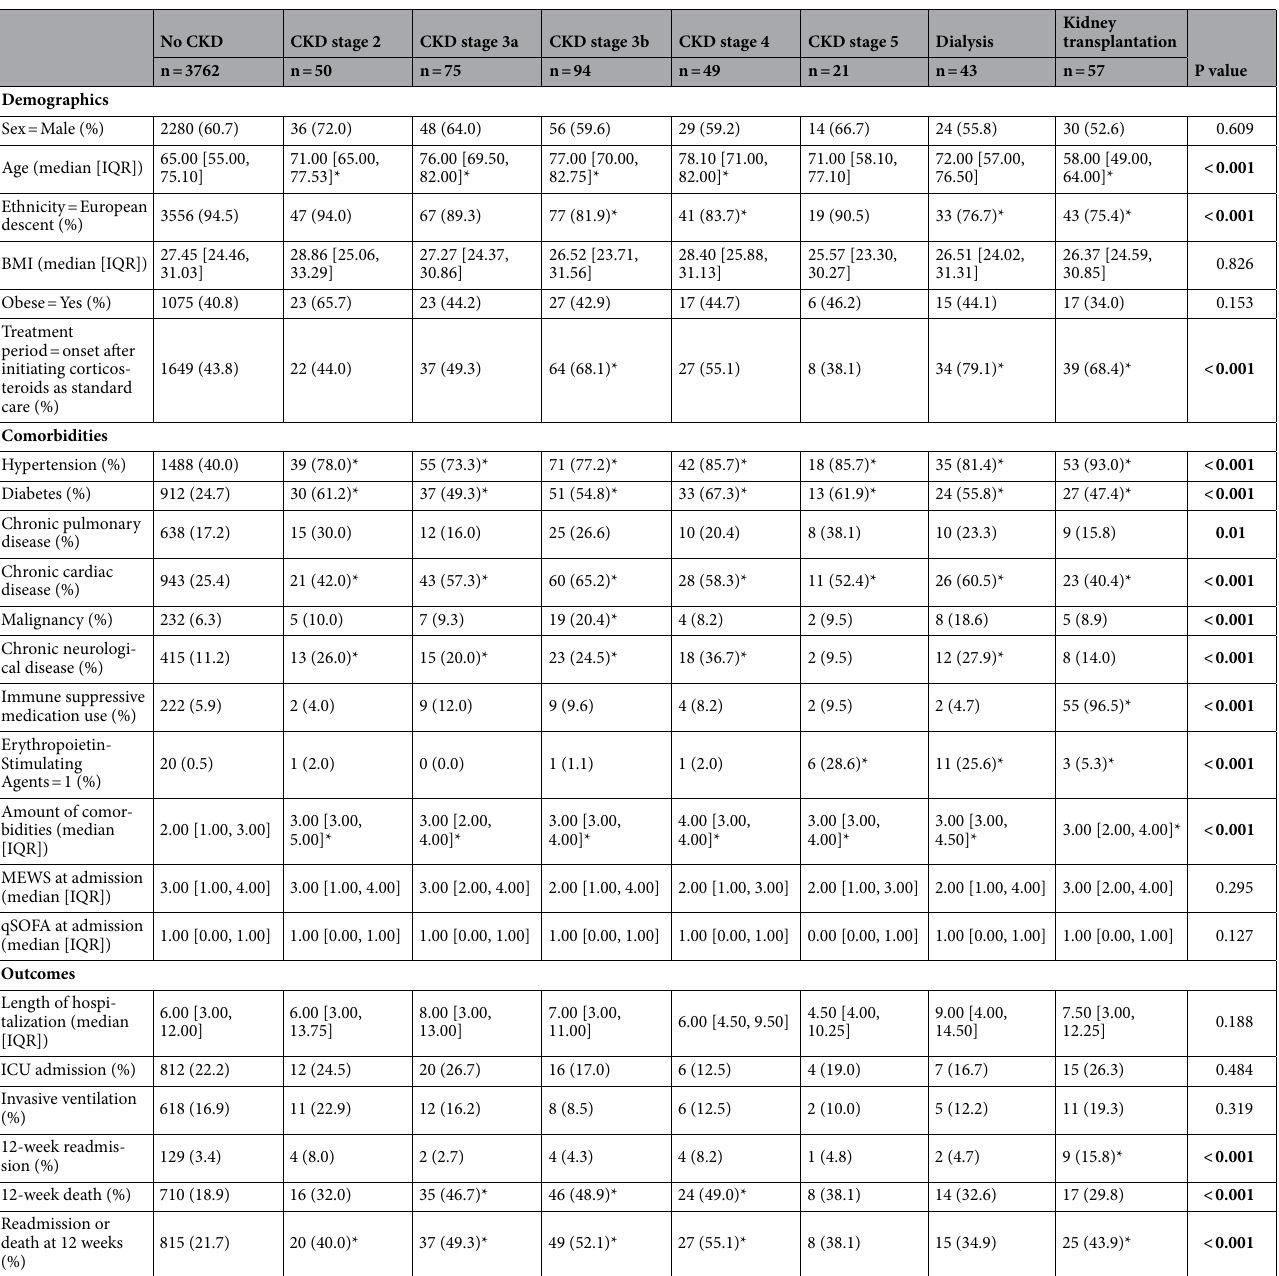
Table 1. Demographics, comorbidities and outcomes in patients hospitalized for COVID-19 among chronic kidney disease groups. Significant values are in bold. Continuous data presented as median [interquartile range], categorical in numbers (%). Continuous variables were compared using the Kruskal–Wallis test, with pairwise Wilcoxon rank tests between No CKD and the corresponding CKD group (Benjamini–Hochberg false-discovery rate adjusted) if overall significant. Significant pairs are denoted with “*”. For categorical data we used the Fisher-exact test to compare group differences , with pairwise post-hoc tests (BH adjusted) between No CKD and the corresponding CKD group if overall significant. CKD stage 2 = eGFR 60–89 ml/ min/1.73 m 2 , CKD stage 3a = eGFR 45–59 ml/min/1.73 m 2 , CKD stage 3b = eGFR 30–44 ml/min/1.73 m 2